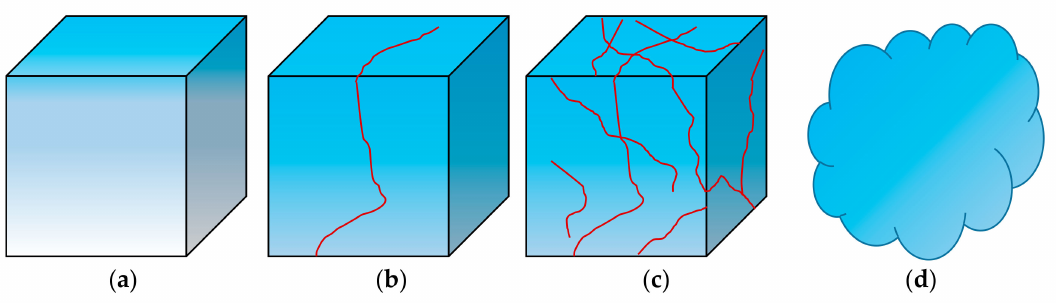
Figure 3. Schematic of pore structure change: ( a ) sediment wetting stage, ( b ) microfracture initiation stage, ( c ) fracture network stage, and ( d ) dispersion stage.